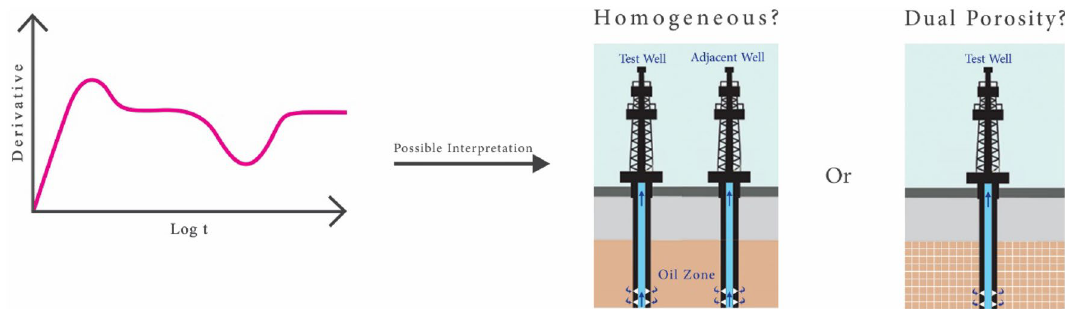
Fig. 1 An example of possible misinterpretation of well test